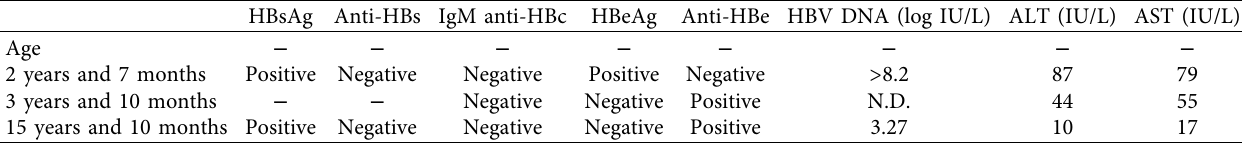
Table 2: Laboratory results of the second